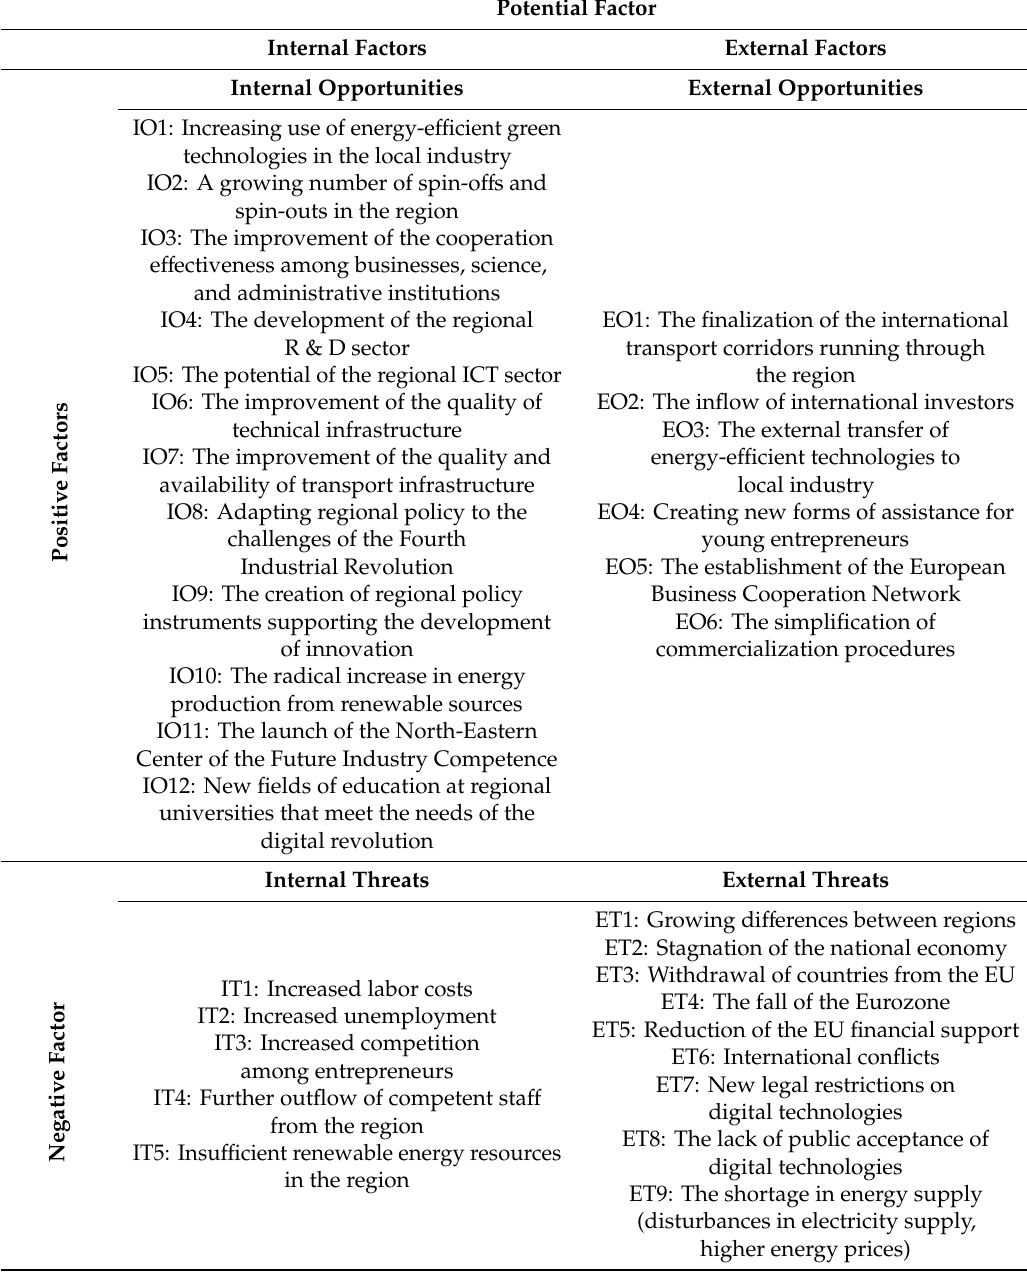
Table 5. SWOT analysis of Podlaskie Voivodeship in the context of the development of Industry 4.0 (potential